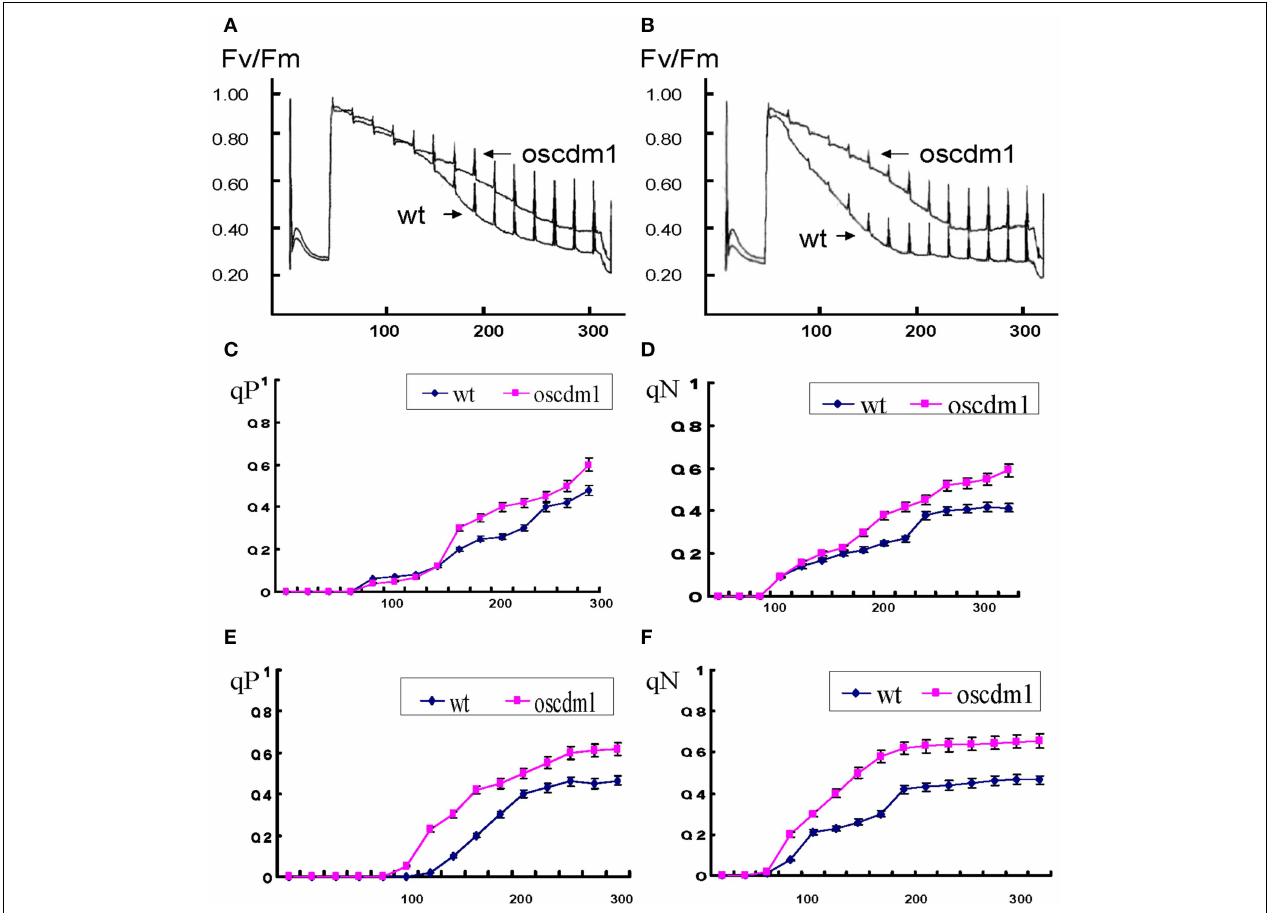
actinic light intensity (57 µ mol/m 2 s). (E,F) , qP and qN changed under a high actinic light intensity (103 µ mol/m 2 s). The data show that qP and qN were not overly different between the wild-type and oscdm1 mutant plants up to 120s of treatment at a low light intensity. However, under a high light intensity the change occurred earlier. This result suggests that the photochemical and non-photochemical quenching capacities of the mutant were affected and that the reaction speed became slower, especially under the higher light intensity. The data are the means ± SD ( n = 5 ). These experiments were repeated more than three times with similar